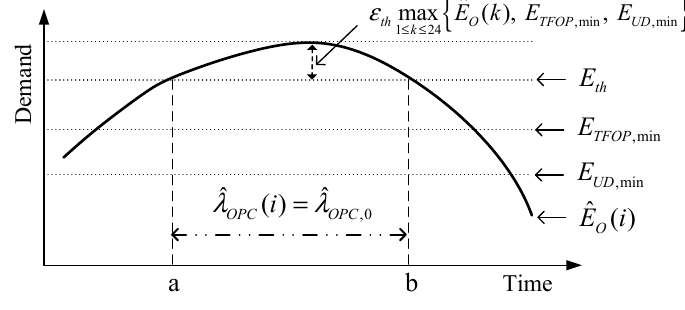
ˆ Figure 3. Concept for determining ˆ λ ( i ) OPC